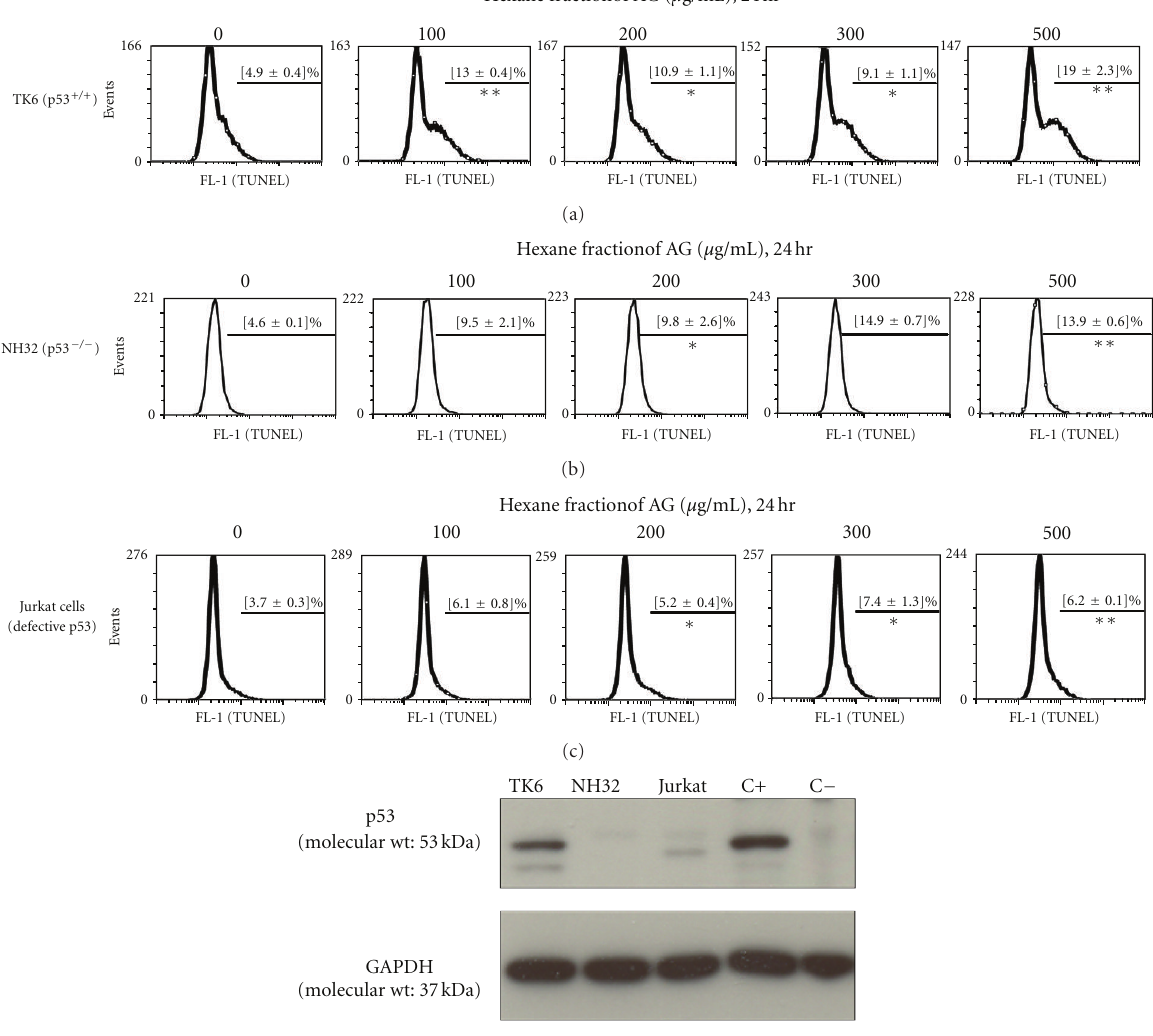
Figure 2: The Hexane fraction of AG (HAG) drives apoptosis (TUNEL + ) of lymphoblasts marginally better in p53 + / + cells compared with p53 − / − cells. The TK6 human lymphoblastoid line, NH32 isogenic p53 knockout cells, and Jurkat T cells (dysfunctional p53 pathway) were cultured in RPMI-1640 + 10% NBCS. Cells were exposed to HAG (in triplicate, n = 3 per treatment) in RPMI-1640 + 0.1% NBCS for 24hr at indicated doses and harvested for TUNEL apoptotic assay. The percentage of the cells (Mean ± S.E.) staining positive for TUNEL, indicating apoptosis are given ( n = 3): (a) TK6 cells; (b) NH32 cells; (c) Jurkat T cells. A minimum of 20,000 events was counted by flow cytometry from each treatment. (d) Confirmation of p53 protein status of the TK6, NH32, and Jurkat T cells. Cell lysates were analyzed by western blot analysis. C+ indicates the positive control for p53, which is an archived HCT-116 cell lysate with wild-type p53. C − , indicates the negative control for p53, which is an archived HCT-116 p53 − / − cell lysate with p53 knockout. Results indicate HAG induces apoptosis in lymphoblasts through a limited p53 activity. Significant di ff erences are indicated, where ∗ P -value < 0.05 and ∗∗ P -value < 0.005, when compared to the control (0 μ g/mL)